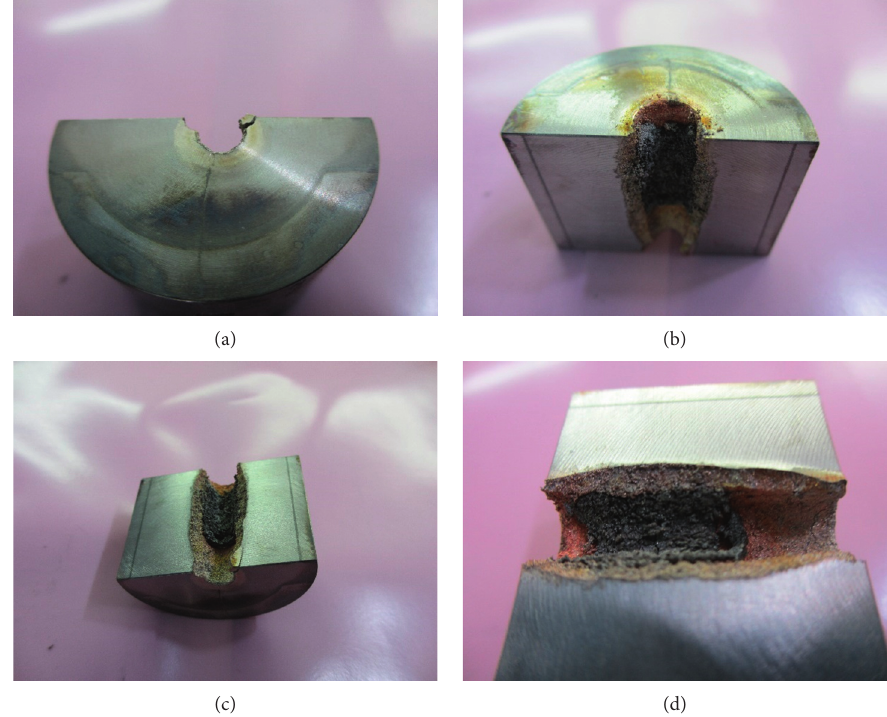
Figure 29: Views of the second Inermet ® 180 specimen after extraction from the HRMT-14 test bench. The crater created by the impact is elliptical, with vertical axis 9.4mm and horizontal axis 8.7 mm. The plastic deformation on the free surface also creates two “lips” spaced vertically by 13.3mm